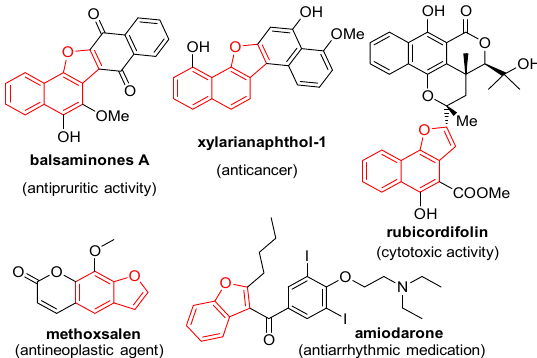
Figure 1. Representative drugs containing benzofuran core.